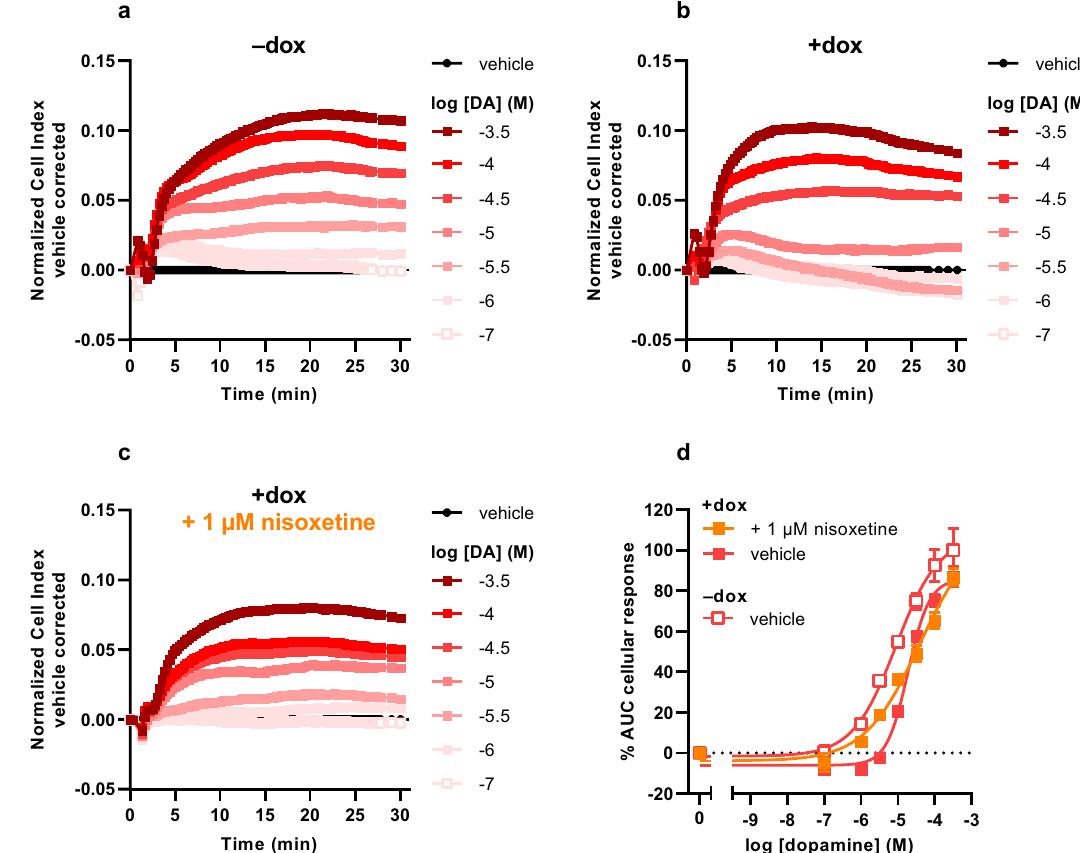
Figure 2. Characterization of the dopamine (DA) response on JumpIn-NET cells in the TRACT assay. Representative vehicle-corrected normalized Cell Index traces of vehicle-pretreated JumpIn-NET cells ( a ) in the absence (−dox) or ( b ) in the presence of 1 µg/ml dox (+dox). ( c ) Dox-treated cells were pretreated for 1 h with 1 µM nisoxetine prior to stimulation with DA. ( d ) Combined concentration-effect curves of DA on vehicle- or dox-treated JumpIn-NET cells. Cellular response is expressed as the net AUC of the first 30 min after stimulation. Data are normalized to the response of 316 µM DA on vehicle-treated (–dox) cells. Data are shown as the mean ± SEM of three to seven individual experiments each performed in